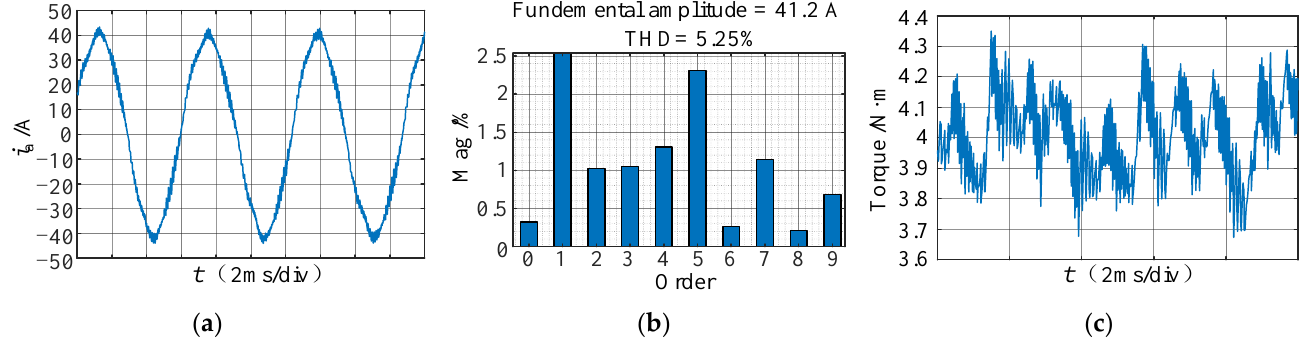
Figure 17. Simulation results under pulse time compensation. ( a ) i as ; ( b ) FFT; and ( c ) output torque.